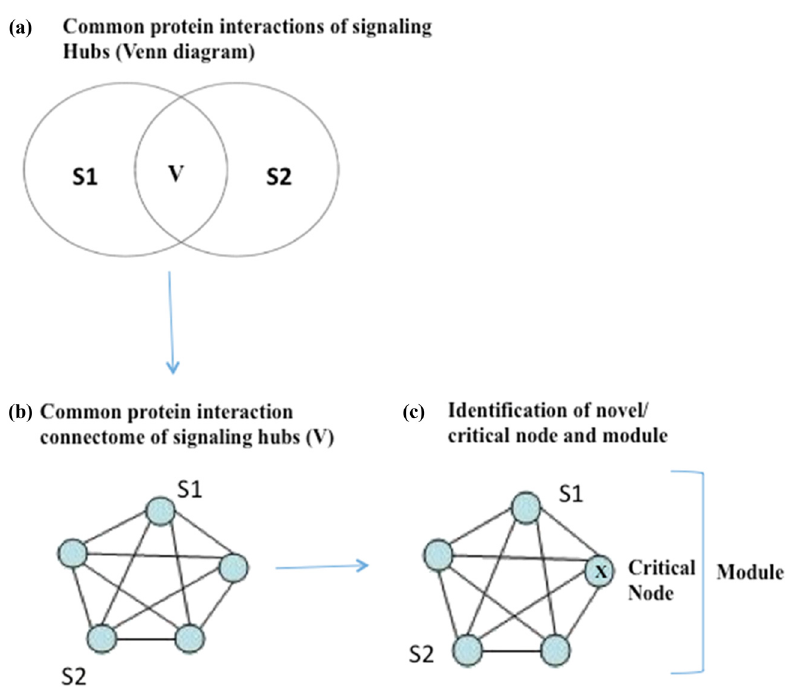
Figure 1: Schematic outline of the PIC - Venn method. ( a ) Common protein interaction partners are designated as C for common signaling hubs S1 and S2. ( b ) Network pathway representation of common interaction partners. Interacting proteins ( hubs ) are represented by circles and interactions ( edges ) by connecting lines. ( c ) Identi fi cation of a critical node and module from the analysis of gene perturbation data ( knockout or overexpression ) in